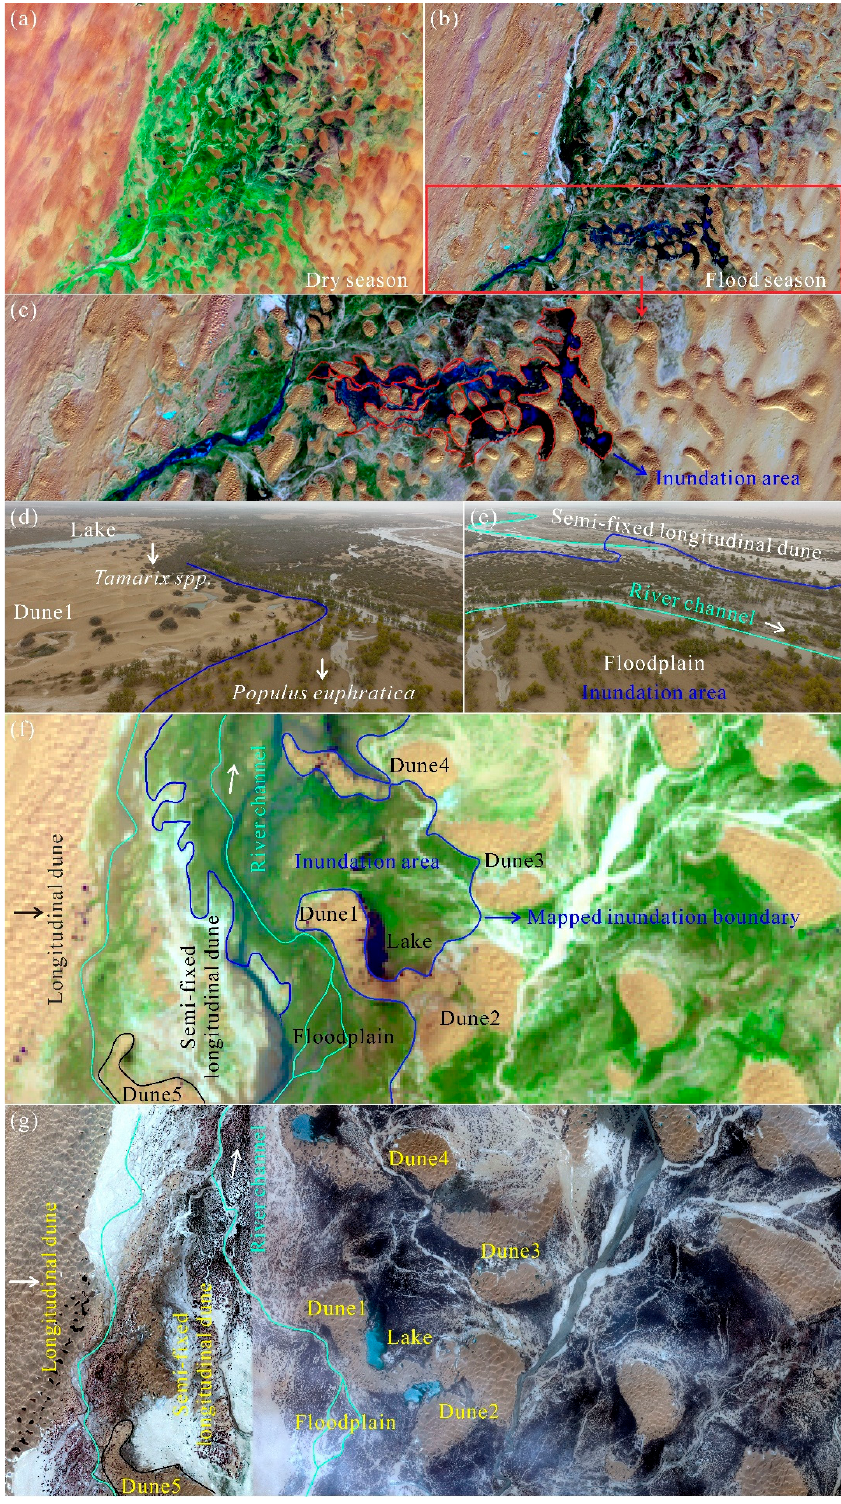
Figure 3. Images illustrating the extraction and measurement of the inundation area and the utilized data validation process. ( a ) Landsat image captured on 17 July 2016, showing no flooding; ( b ) Land- sat image captured on 8 December 2016, showing flooding. ( c ) The red area represents mapped inundation area; ( d , e ) are UAV aerial photographs captured on 7 October 2016. ( f ) Landsat image captured on 11 March 2016; ( g ) Google Earth images acquired on 25 June 2011 and 16 March